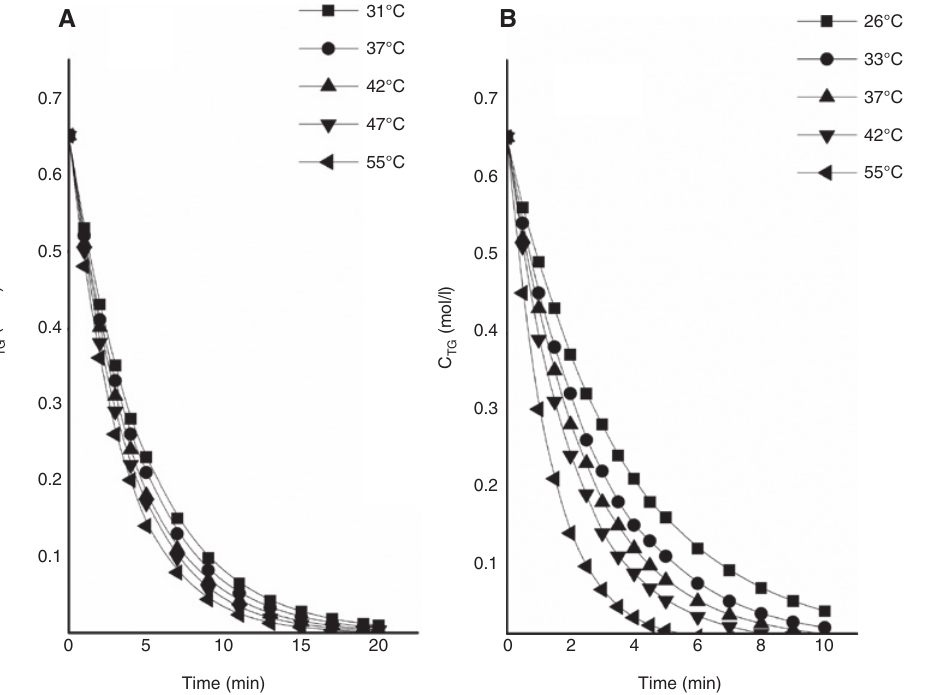
Figure 3: The kinetics curves of the transesterification under (A) the CH condition and (B) the MWHCC condition in different temperatures.